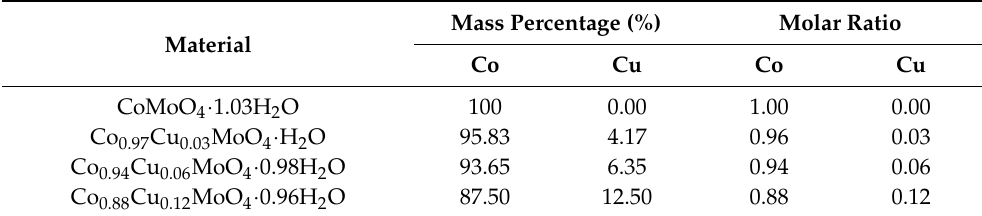
Table 3. Mass percentage and molar ratios of Co, Cu taken from EDS spectra in the Co 1 − x Cu x MoO 4 · nH 2 O compounds.